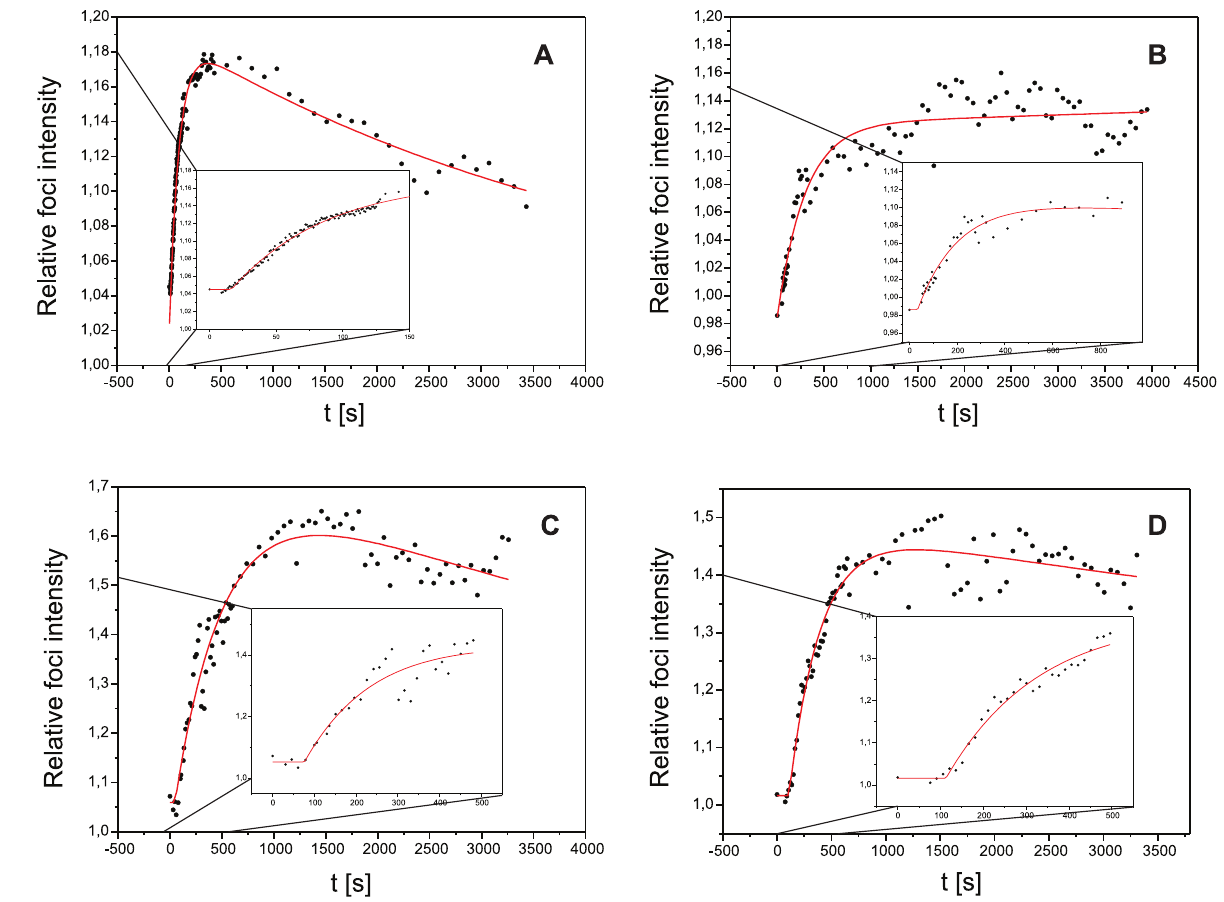
Figure 2. Foci intensity vs. time after irradiation. The relative foci intensity I rel = I foci /I nucl of Mdc1 after irradiation with 5.2 Gy of 43 MeV carbon ions (A) and 4.8 Gy of 20 MeV protons (B) and 53BP1 after 7.6 Gy carbon (C) and 6.9 Gy proton irradiation (D) plotted for one cell and fitted with our model function (eq. 1). Irradiation took place on t =0. The insets show the protein accumulation after the irradiation with splayed time-axis.